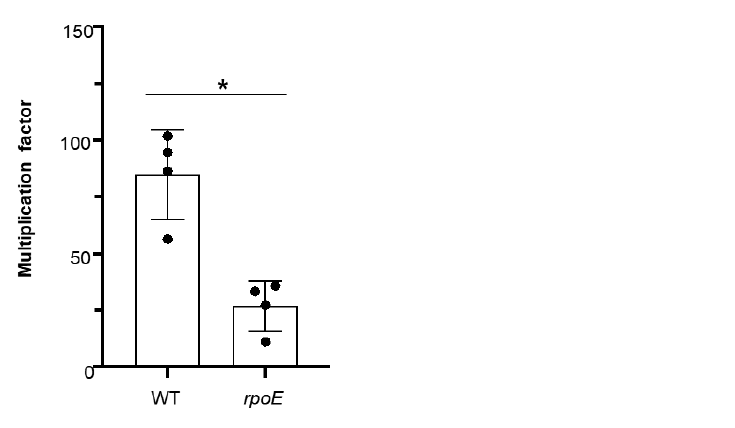
Figure 2. Mutation of rpoE in M1T1 5448 reduces survival in human blood. A Lancefield bactericidal assay in non-immune whole human blood was performed using WT 5448 (WT) and a rpoE mutant ( rpoE ). Asterisk indicates statistical significance ( p ≤ 0.05) by comparison to the WT as determined by an unpaired t -test.